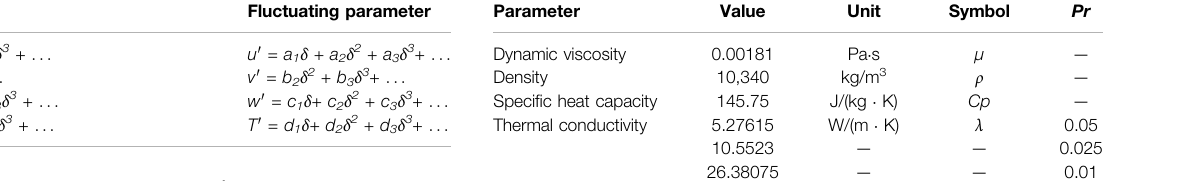
TABLE 2 | Series expansion near the wall. Mean parameter